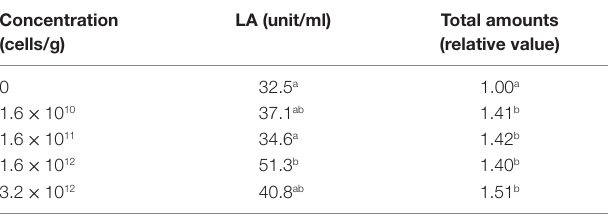
TABLe 2 | Mucus status of red sea bream fed with diets containing different concentrations of inactivated Pediococcus pentosaceus.